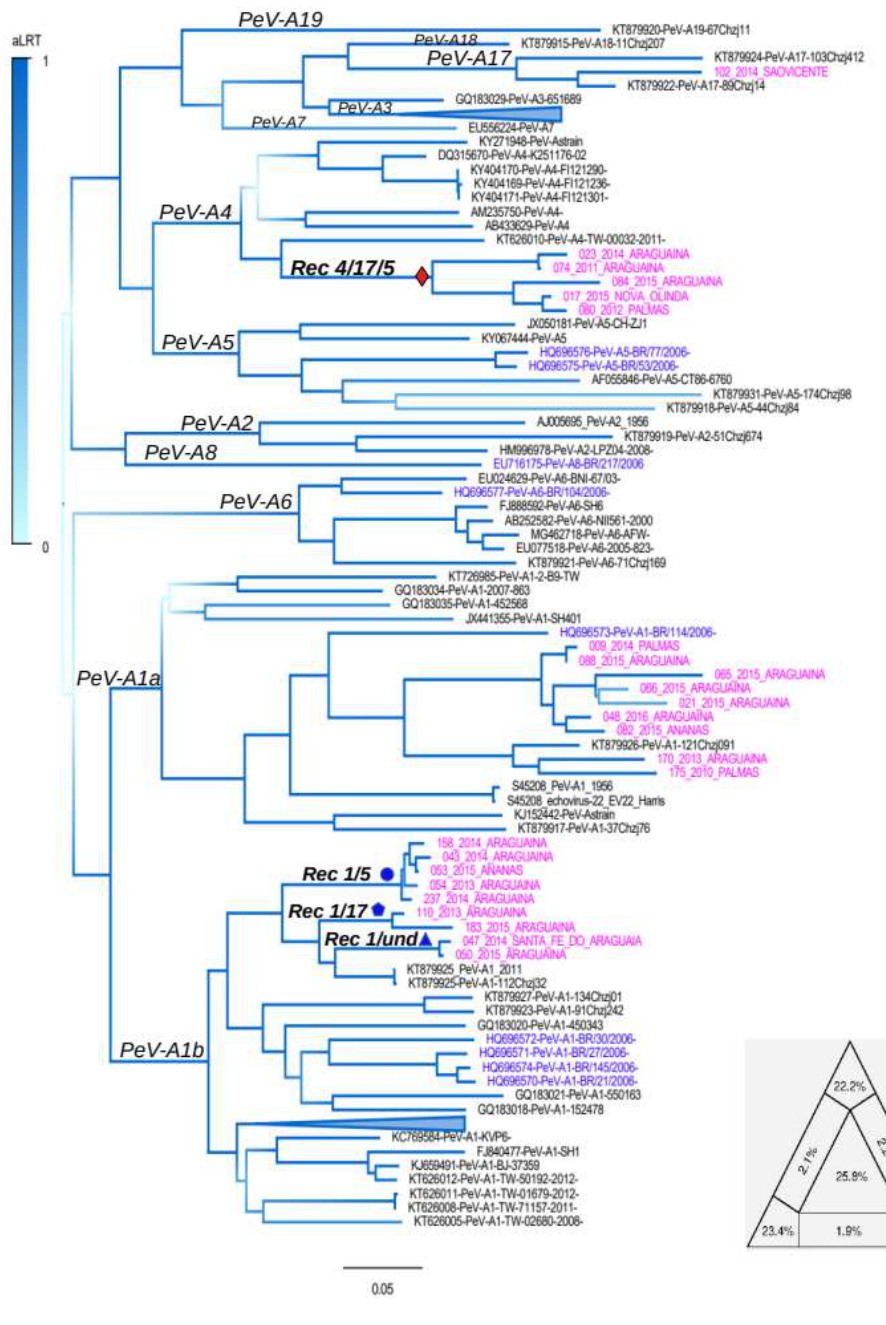
Figure 2. Maximum likelihood tree constructed using near-full length genome of PeV-A. The Brazilian strains described in the present study (diamonds) and from previous studies (arrows) are indicated in the tree. A colored scale indicating the statistical support of each node, calculated using aLRT, is shown in the tree. Phylogenetic groups corresponding to main genotypes (only the genotypes in which full length genomes were available) are indicated. The scale bar under the tree represents the nucleotide substitutions per site. | A maximum likelihood tree was inferred assuming the GTR + gamma model and was constructed using the software FastTree [24]. The triangle in the base of the tree is the likelihood map and it shows 25.9% of unresolved trees in the PeV-A genome alignment. Likelihood mapping was obtained using the software Tree-puzzle, version 5.3 [26], assuming the GTR model and the rate of heterogeneity for the evolutionary model. Analyses were performed using 1000 replications.